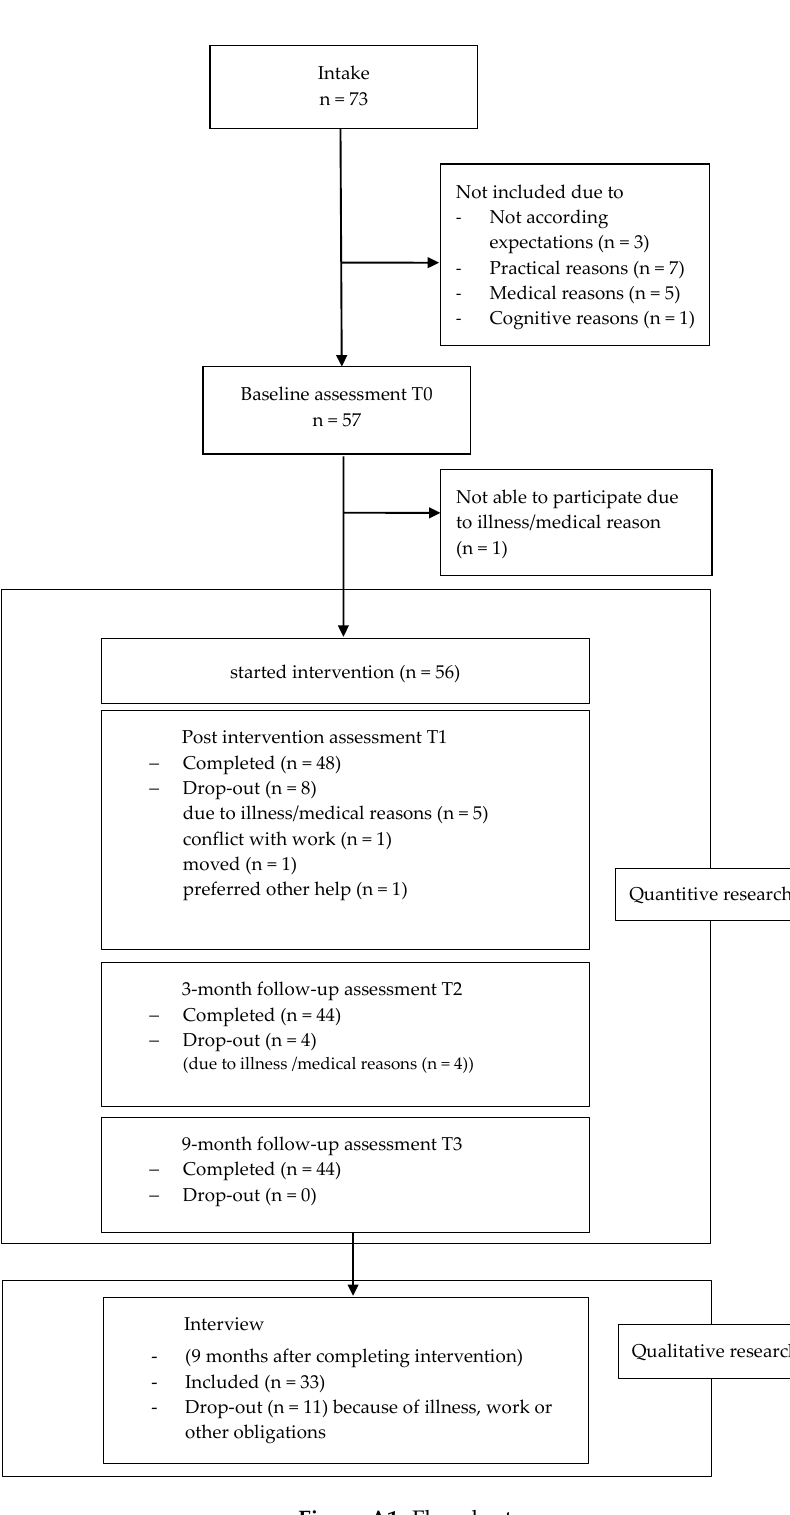
Figure A1. Flowchart . Figure A1.